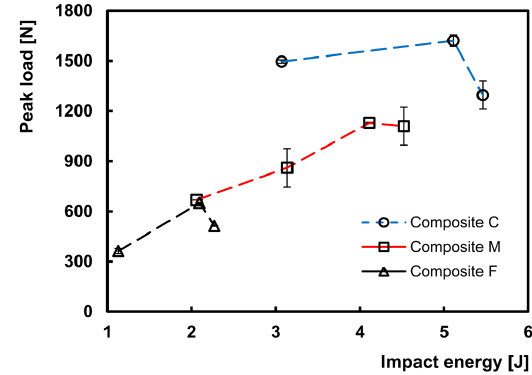
Figure 9. Exemplary curves of the energy versus time during impact tests.